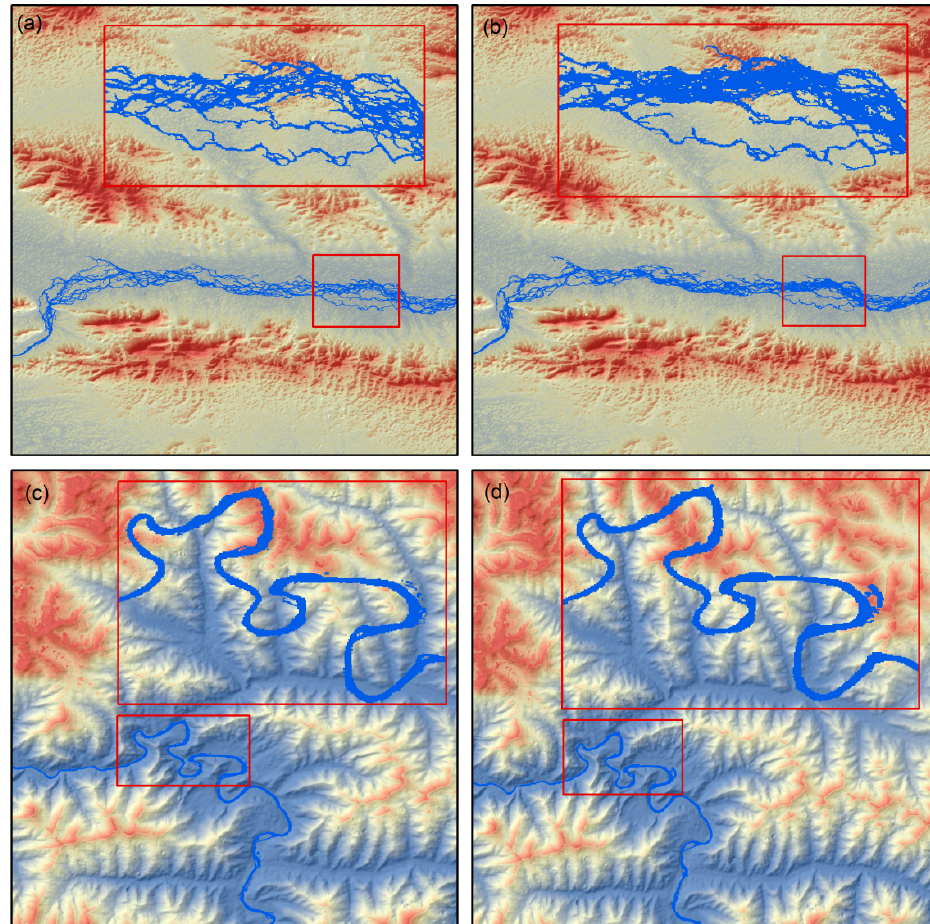
Figure 3. Comparison of water bodies in 2020 extracted for reach A ( a , b ) and reach G ( c , d ) of the Tongtian River using the combined method ( a , c ) and the JRC dataset ( b , d ). An inserted image with a red rectangle is used to show the enlarged view of a local reach with a smaller red rectangle.